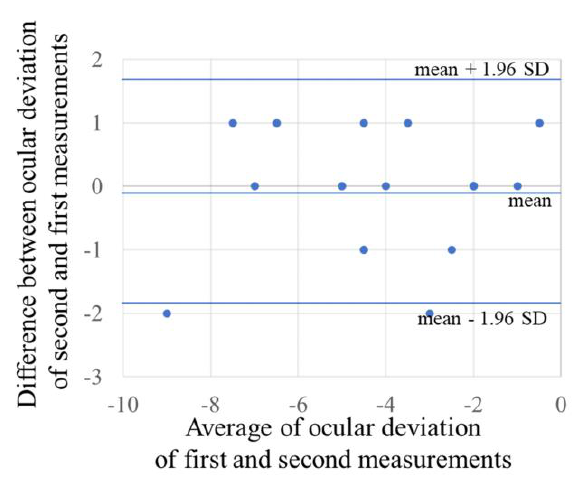
Figure 4: Bland–Altman analysis of the reproducibility of the OMD